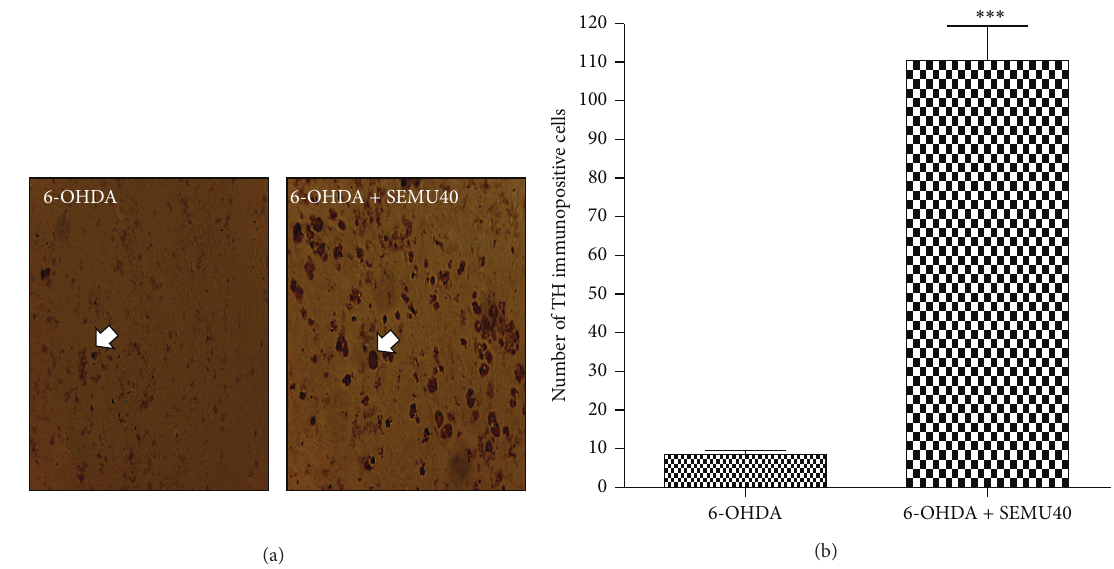
Figure 5: Immunohistochemistry for tyrosine hydroxylase (TH, a rate limiting enzyme for dopamine biosynthesis), in the lesioned right striatum (a). The untreated 6-OHDA group shows almost no TH immunopositive cells, as related to the 6-OHDA group after SEMU treatment, at the dose of 40 mg/kg, p.o. (magnification: 400x). Arrows indicate TH immunopositive cells. (b) shows the means ± SEM of the number of TH immunopositive cells (three different fields) in each group. ∗∗∗ versus the untreated 6-OHDA group ( 𝑡 = 16.74 , df = 7.0, 𝑃 < 0.0001